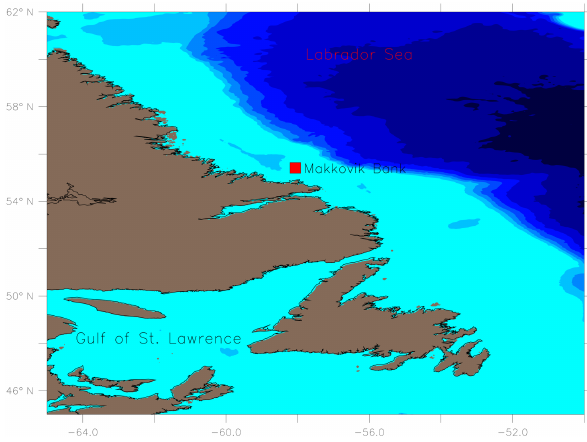
Figure 1. The location of ULS instrument.